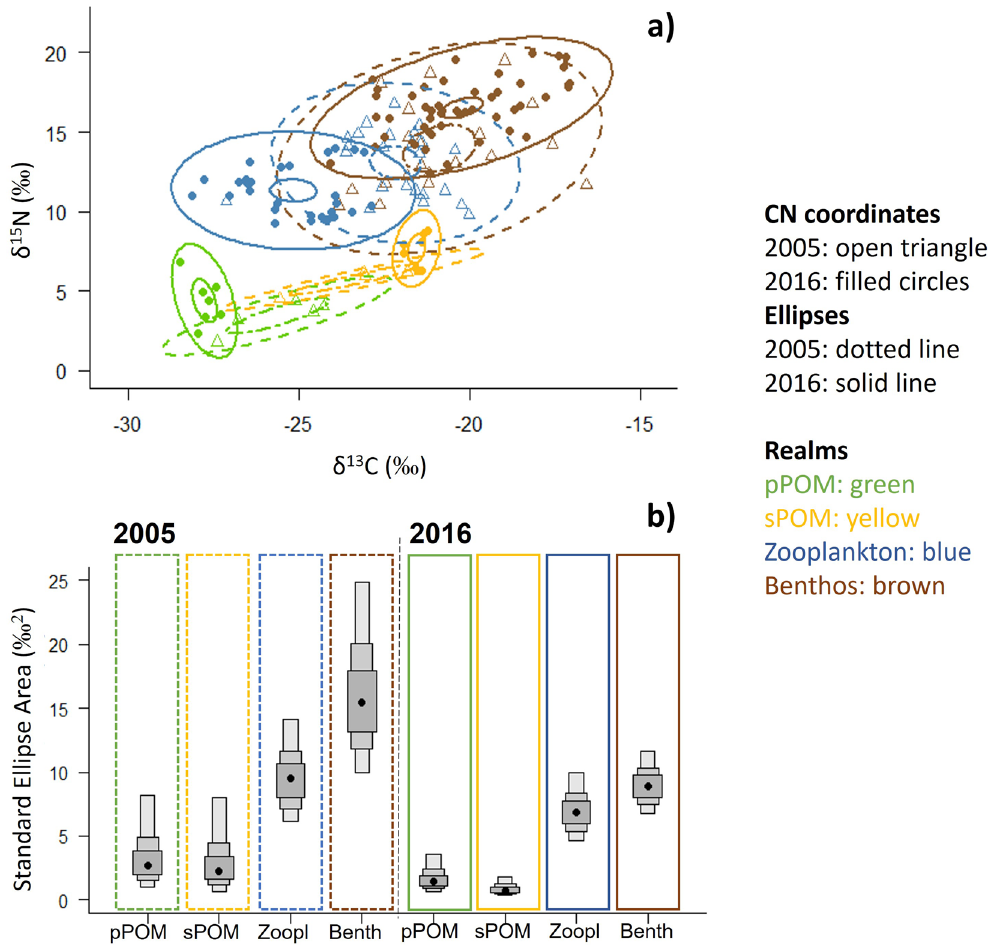
Figure 4. Isotopic niches of compared food web components in the study area. ( a ) Biplot of δ 13 C and δ 15 N isotope values (‰) for assemblages in the Chukchi Borderland in 2005 and 2016; outer ovals are sample size corrected standard ellipses (SEA C ) containing 95% of the data. Inner small ovals indicate 95% confidence intervals around the bivariate means. Open triangles are means of samples collected in 2005 and filled circles in 2016. Food web endmembers and consumers are indicated by colors: green (pPOM), yellow (sPOM), blue (zooplankton), and brown (benthos). See Table 3 for pPOM and sPOM abbreviations. ( b ) Standard ellipse areas Bayesian estimations (SEA B ) presented as credible intervals for each of the community components for the two sampling years; black dots are the mode of the SEA B (‰ 2 ), the shaded boxes represent the 50% (dark grey), 75% (lighter grey) and 95% (lightest grey) credible intervals. Dotted outlines enclose assemblages collected in 2005 and solid lines represent those collected in 2016. Total amount of zooplankton taxa consisted five for both